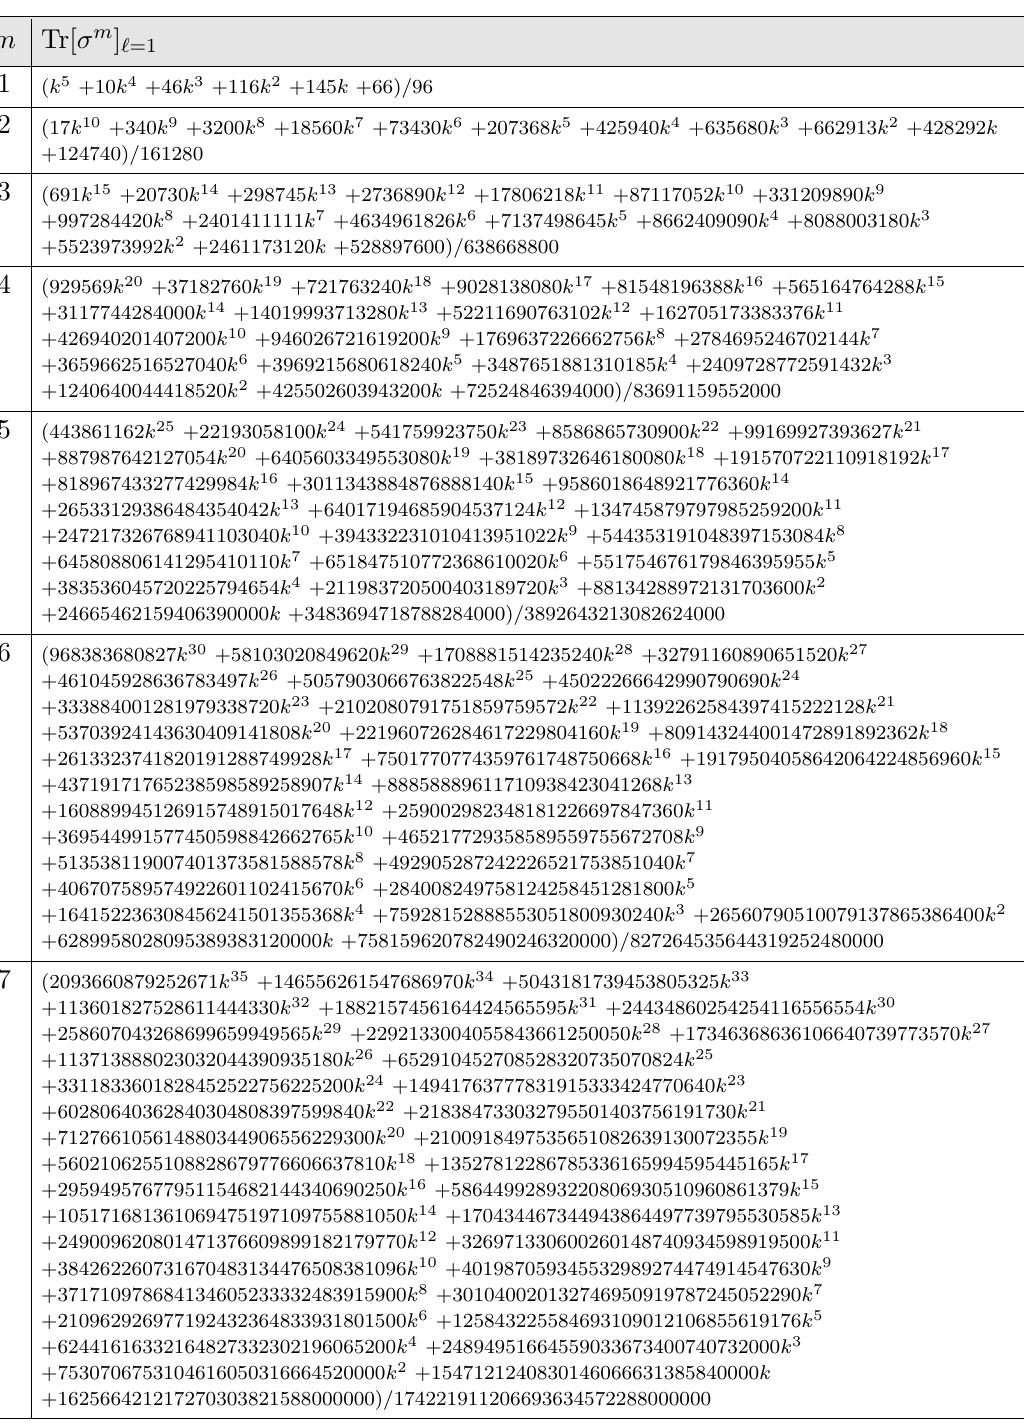
Table 4. The values of Tr [ σ m ] as a function of k for T 3 , 6 torus link. The subscript ‘ indicates that the polynomial is valid for k ≡ ‘ ( mod 2)